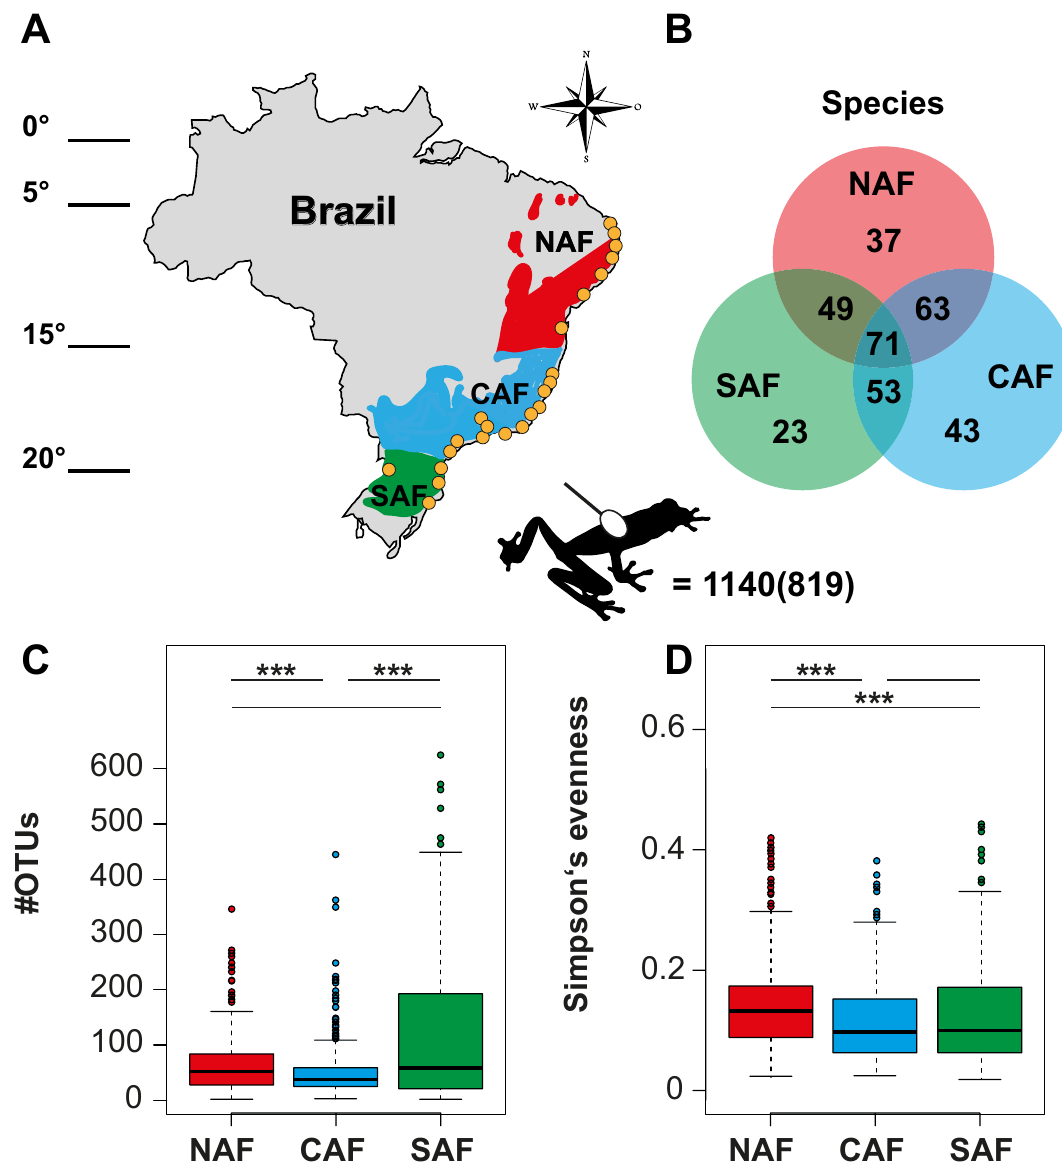
Figure 1. ( A ) Map of the three climatic regions of the Atlantic Forest (sensu 45 ). We sampled skin microbiomes of 1140 treefrogs (Anura: Hylidae and Phyllomedusidae) from ( B ) 71 species over a latitudinal transect at the Atlantic Forest from 23 localities (i.e. orange dots) to test for differences in the amphibian skin bacterial community. 819 treefrogs remained in analysis after rarefaction ( C ) Number of operational taxonomic units (OTUs) were calculated as a measure of amphibian skin bacterial richness. ( D ) Simpson’s evenness was calculated as a measure of amphibian skin bacterial abundance. Differences between latitudinal groups were analyzed using a Kruskal–Wallis test, followed by Dunn’s post-hoc tests with Bonferroni correction. The map ( A ) was created with Adobe Illustrator 2021. NAF = North Atlantic Forest. CAF = Central Atlantic Forest. SAF = South Atlantic